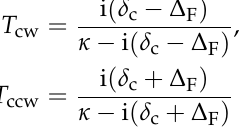
Figure 4. (Color online) Transmission probability detuning δ c for various values of the Fizeau shift ∆ F . The dashed (red) curve denotes the transmission probability for the cw input, while the solid (blue) line denotes the transmission probability for the ccw input. Parameter in ( a – c ): G ccw = 2 κ ; ( d – f ): G ccw = 0.5 κ . Other parameters are the same as those in Figure